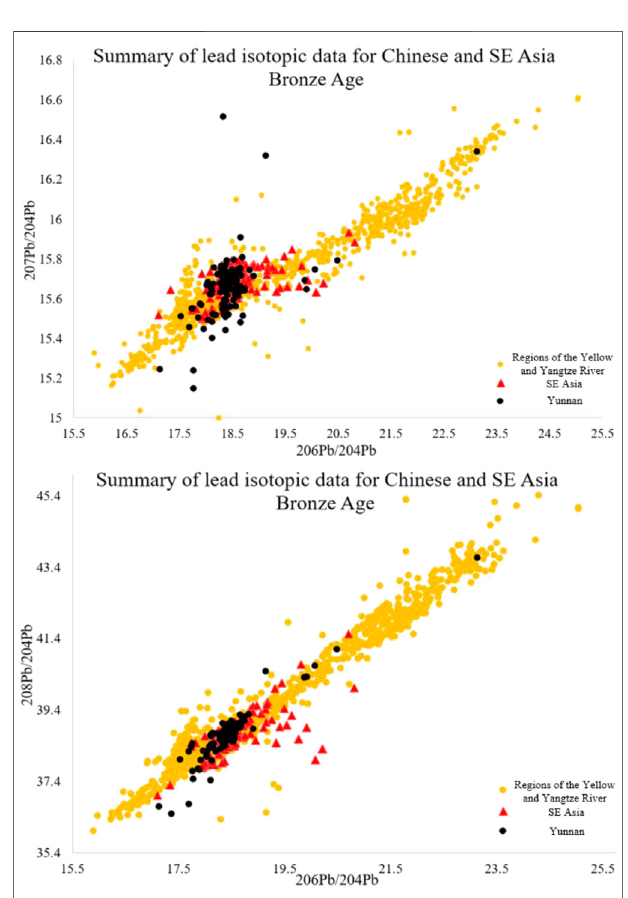
FIGURE 7 | Comparison of lead isotopic data from copper-based artifactsfromYunnanandSEAsia(datafromhttps:// fl ame.arch.ox.ac.uk/,see also Perucchetti et al.